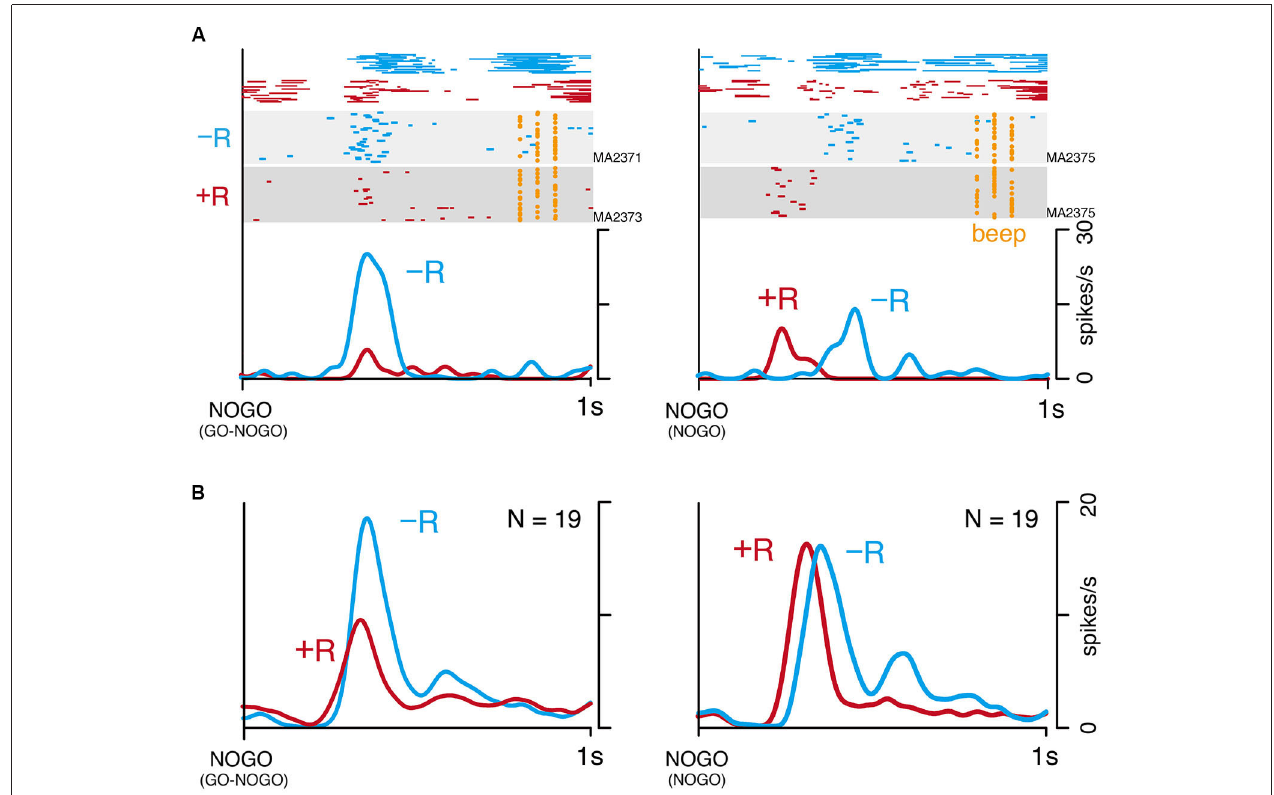
separately plotted by reward condition ( − R, blue; + R, red). (B) Population histogram (smoothed, SD = 20 ms) of 19 LLF neurons responding to NOGO instructions in GO-NOGO task (left) and NOGO task (right). Activities are